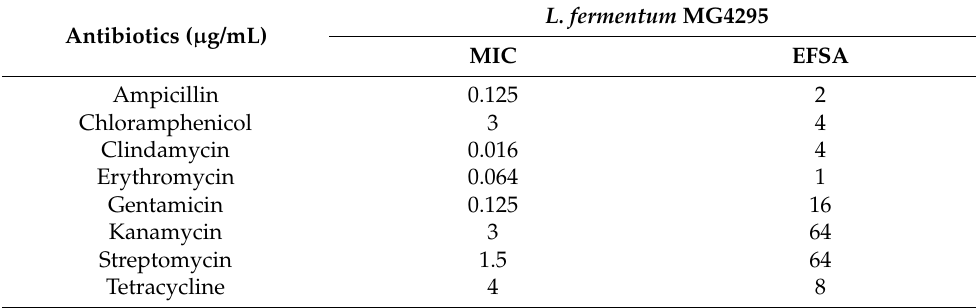
Table 2. Results of minimum inhibitory concentration test for the probiotic candidate L. fermentum MG4295.